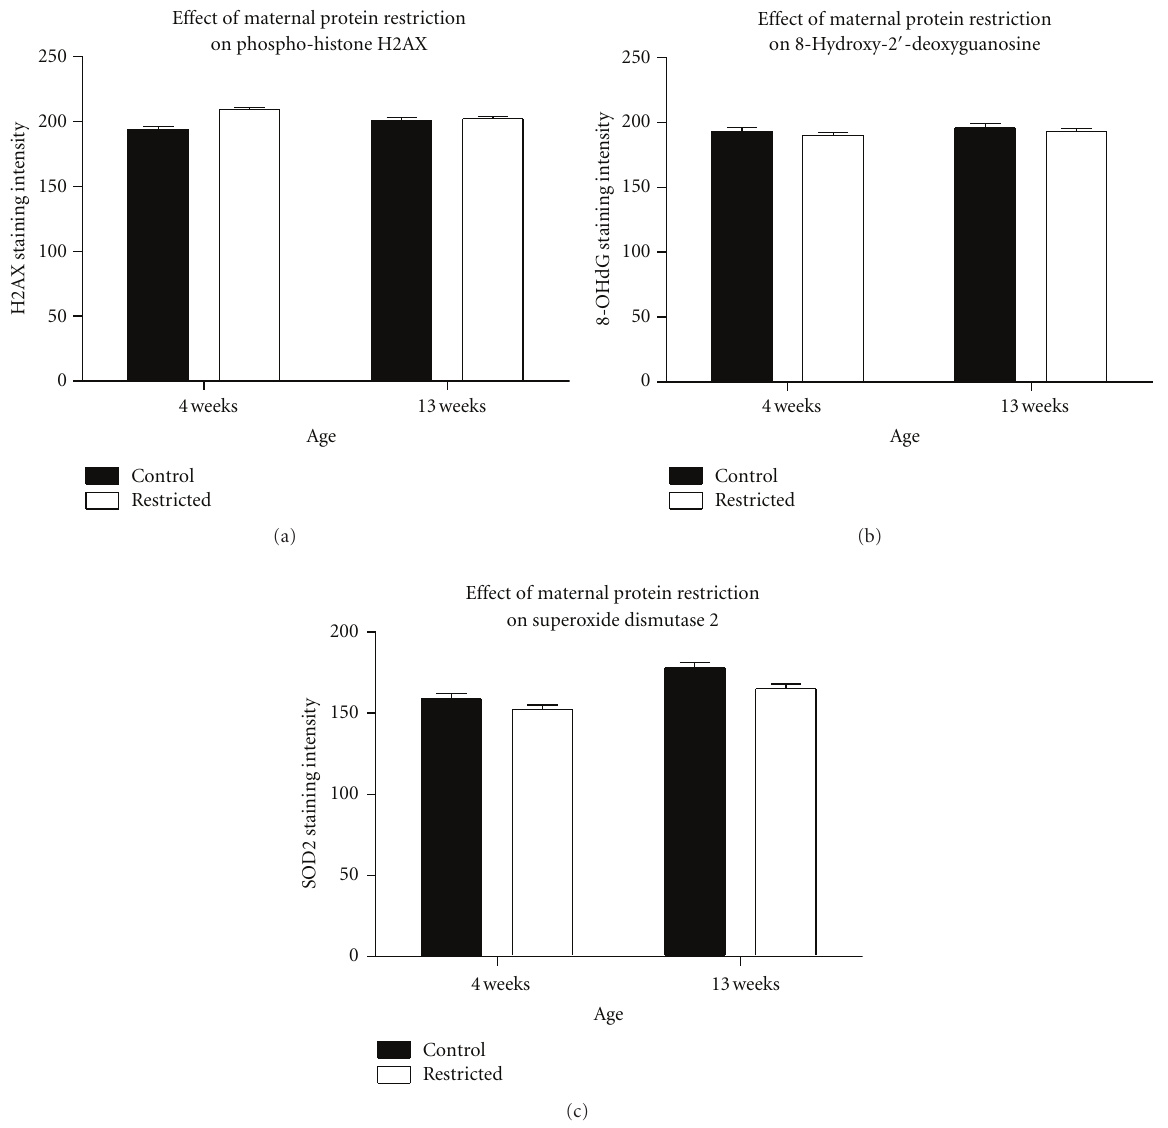
Figure 2: Oxidative stress in kidney tissue as measured by immunohistochemistry. Markers of oxidative stress within the mitochondria were una ff ected by maternal protein restriction. Values are means ± S.E.M. n =